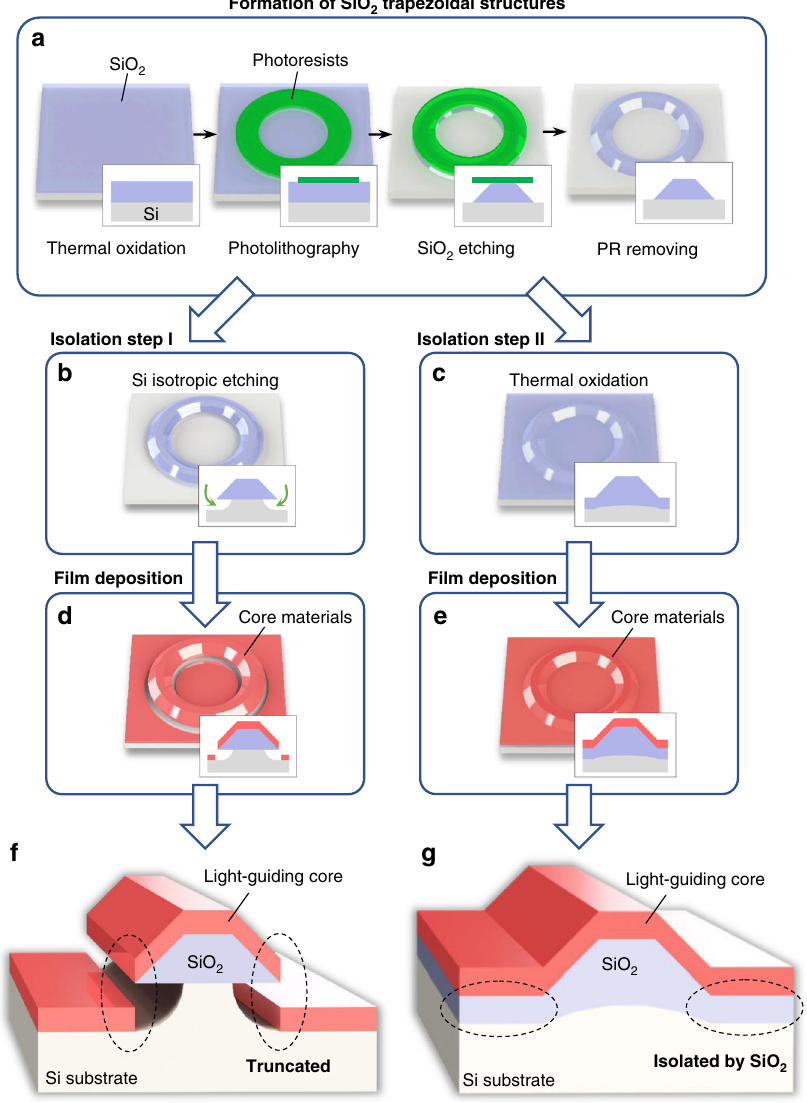
Fig. 4 Fabrication procedure to realize the high- Q resonator (or the trapezoidal waveguide) on a chip. a Sequence to form SiO 2 trapezoidal structures. b Isotropic XeF 2 etching of a Si substrate to isolate an optical fi eld from the substrate. c Additional thermal oxidation as an alternative to the isolation step. d Film deposition of core materials on the XeF 2 etched structure. e Film deposition of core materials on the additionally oxidized structure. f The XeF 2 - etched high- Q resonator in which the fi lm of the core material is truncated at the end of the wedge structure. g The additionally oxidized high- Q resonator in which the fi lm of the core material is isolated from Si substrate by the SiO 2